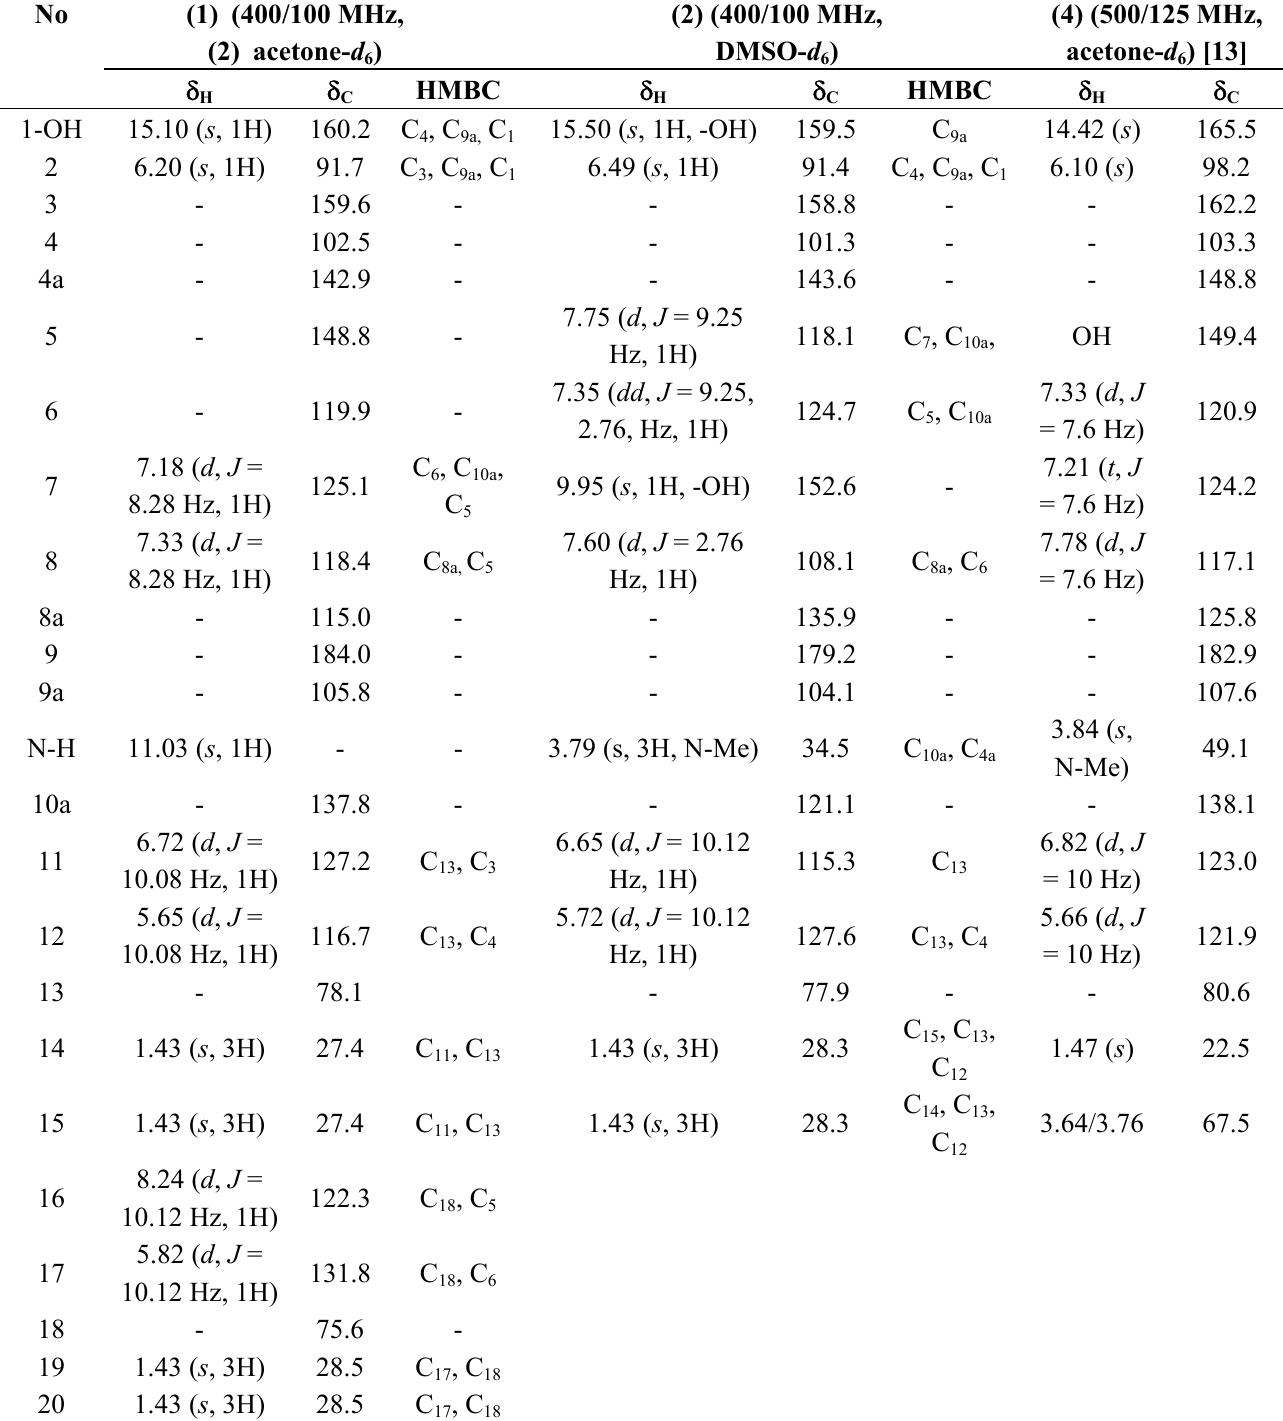
Table 1. 1 H-NMR and 13 C-NMR spectral data of macranthanine ( 1 ), 7-hydroxynoracronycine ( 2 ) and 5-hydroxynoracronycine alcohol ( 4